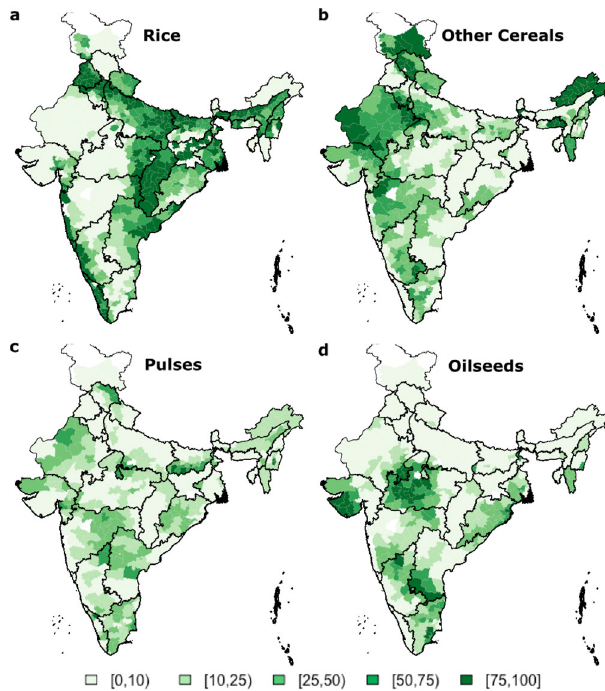
Fig. 1 Current cropping pattern in India shown as percentage net-cropped area in Kharif season. Twelve primary crops procured by the Ministry of Agriculture, Government of India, are grouped into rice ( a ), other cereals (bajra, maize, jowar, and ragi) ( b ), pulses (tur and other pulses) ( c ), and oilseeds (groundnuts, sesamum, soybean, nigerseed, and sun fl ower) ( d